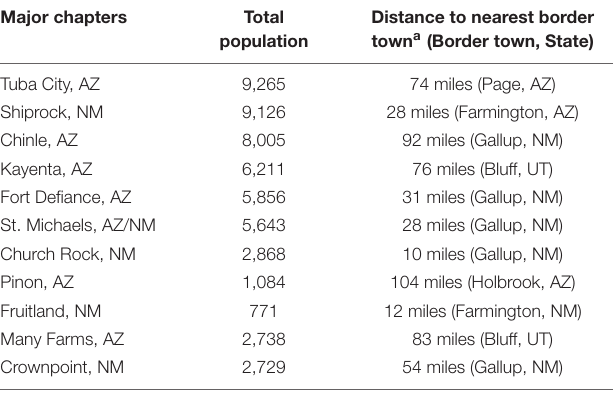
TABLE 1 | Most populated chapters and driving distance to the nearest border town. Major chapters Total population